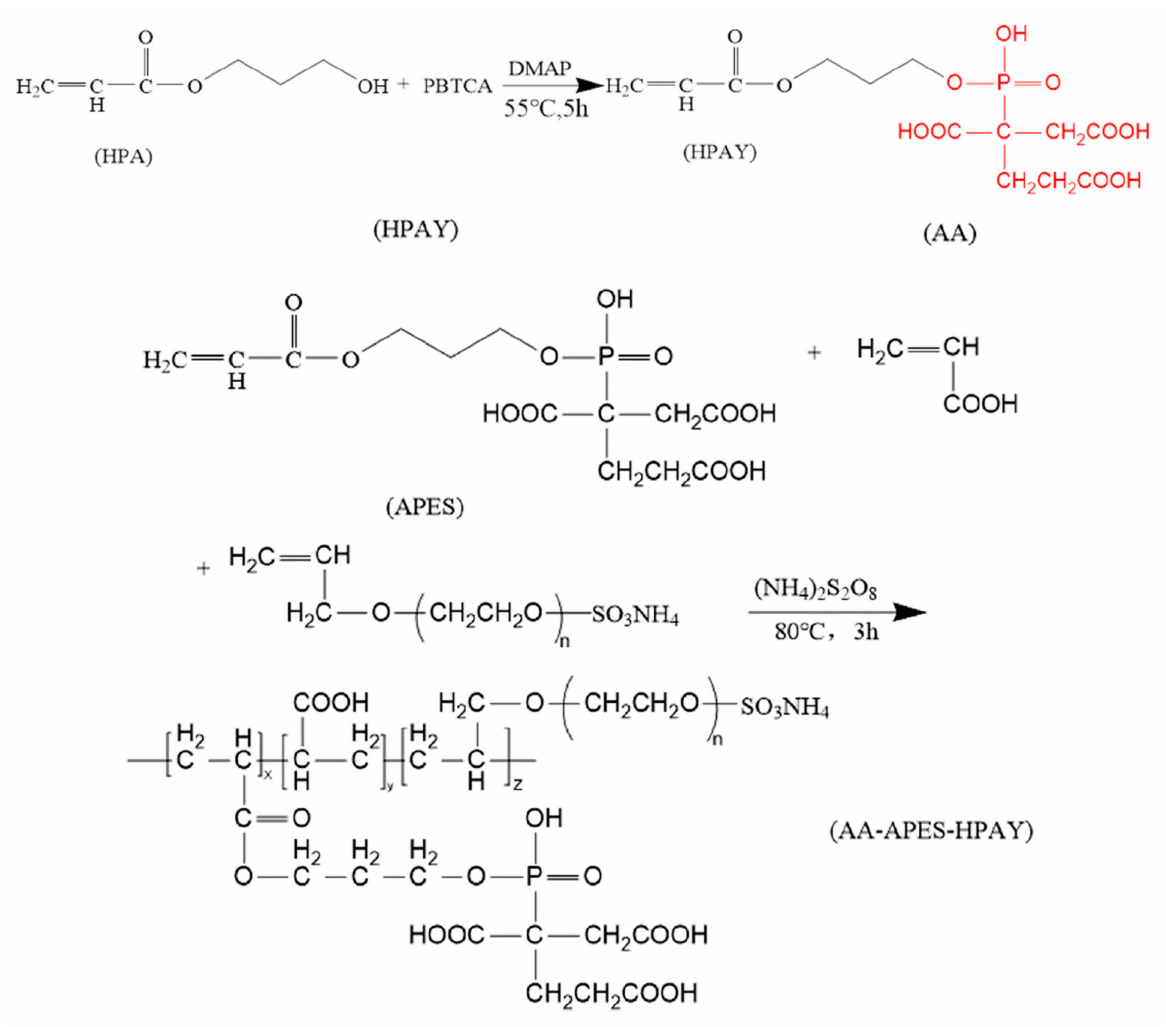
Figure 12. Synthesis of AA − APES − HPAY [128].